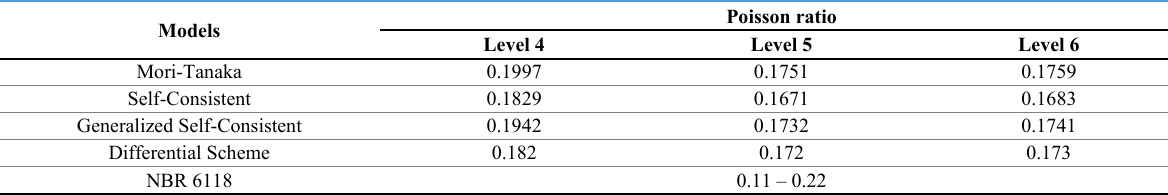
Table 9: Numerical results by homogenization steps for Poisson's ratio (without ITZ).